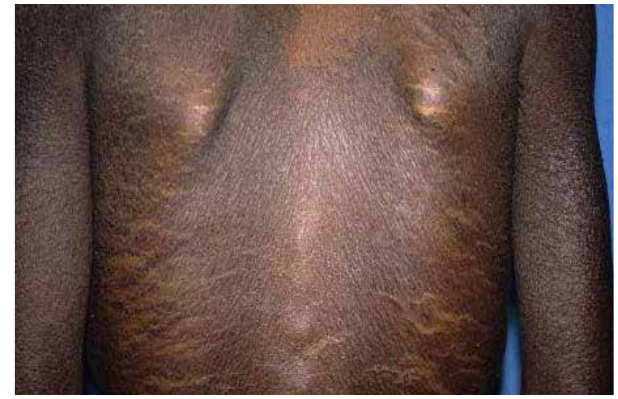
Figure 10. Marked xerosis and acquired ichthyosis in